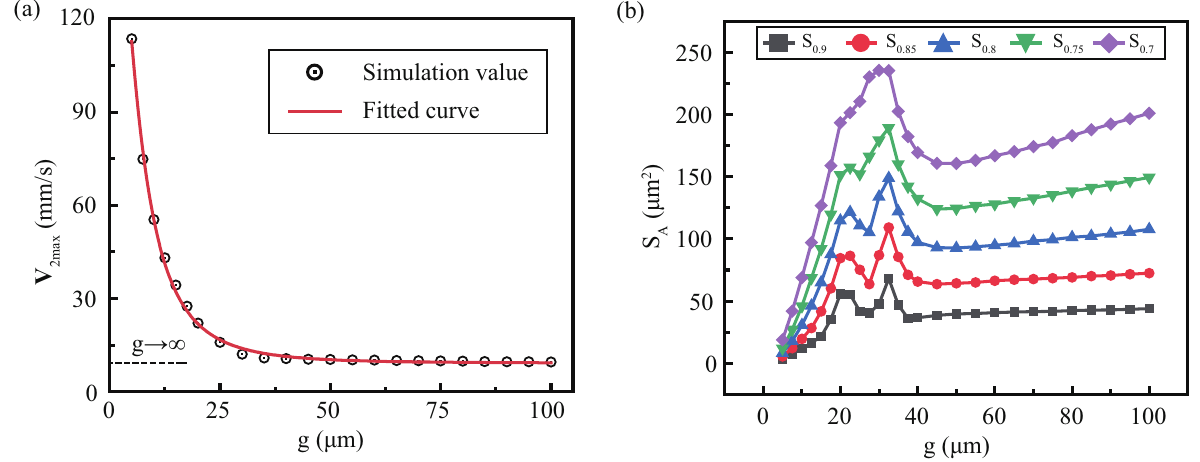
Figure 5. The gap effect on streaming is revealed by quantitative parameters: ( a ) V 2 max changes obvi- ously, where the black discrete point is the numerical value, and red is the fitting curve when it tends to infinity, which is approximately equal to V ∞ , such as the black dotted line. ( b ) Effective areas 2 max S A changes are complex, including S 0.9 , S 0.85 , S 0.8 , S 0.75 and S 0.7 . Constant parameter: h = 100 µ m, α = 90 ◦ , f = 10 kHz, η = 0.89 mPa ·